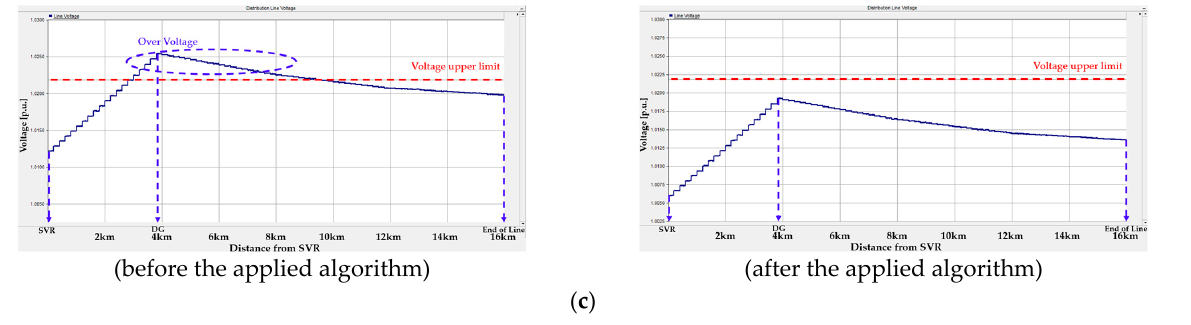
Figure 14. Distribution line voltage profiles by conventional and proposed voltage control in Type 3: ( a ) Case I; ( b ) Case II; ( c ) Case III.